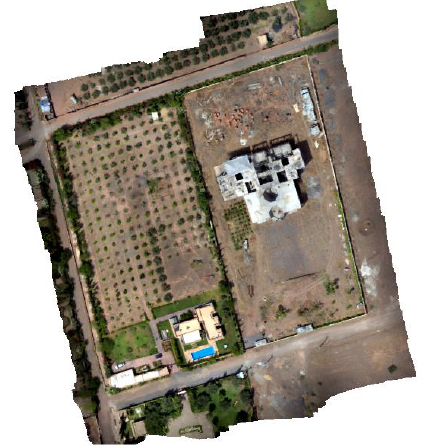
Figure 7 . Orthophoto with a ground sample distance of